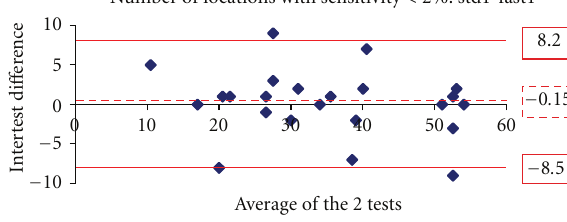
Figure 1: The Bland-Altman plot showing agreement in mean deviation between the 10-2 SITA-standard and SITA-fast tests dur- ing the first visit. The dashed line marks the average di ff erence be- tween the two algorithms. The solid lines mark the upper and lower limits of the 95% limits of agreement.